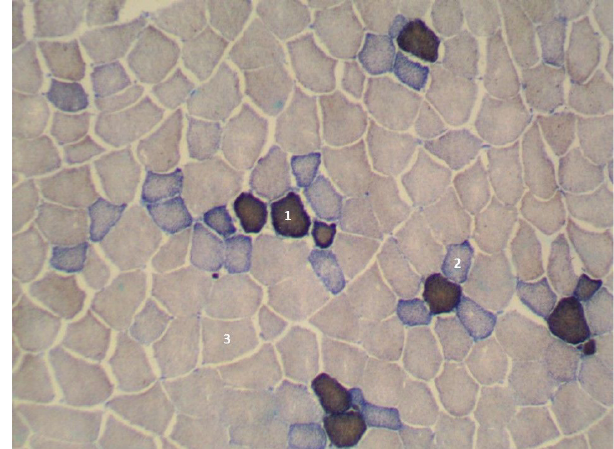
Figure 2. Cross section of the longissimus lumborum muscle in Naima pig. Magnified 100 times. STO is indicated by 1, FTO is indicated by 2 and FTG is indicated by